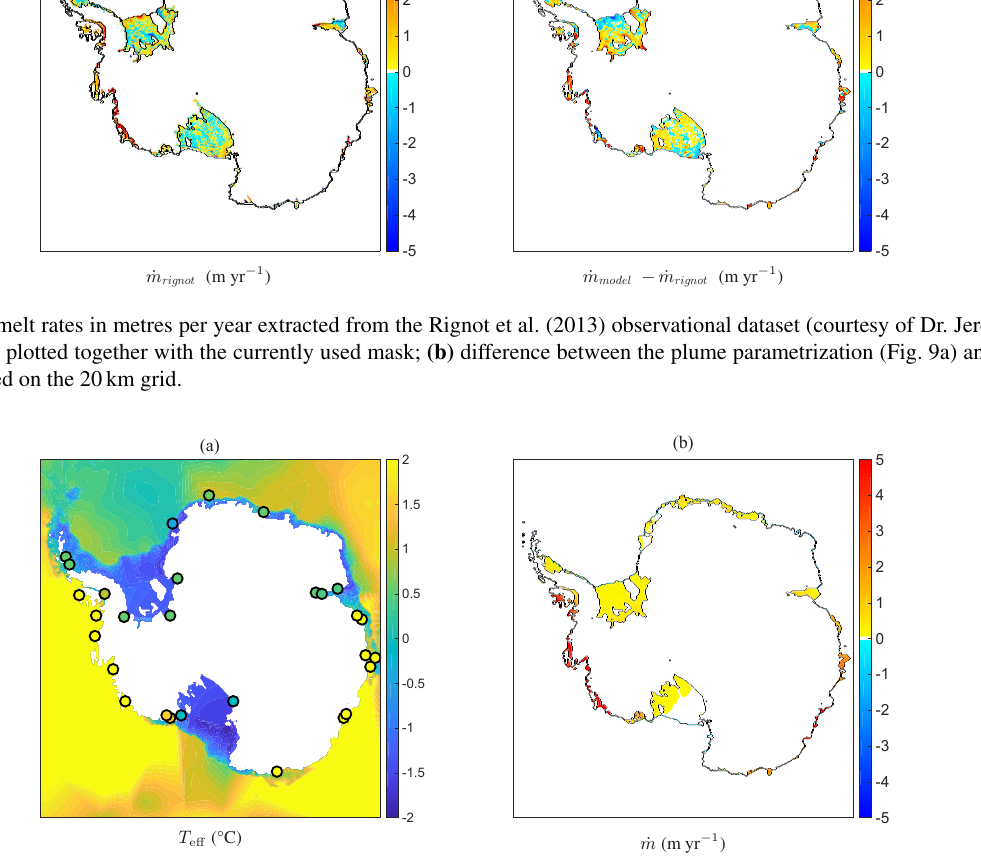
Figure 12. (a) Effective temperature field constructed in a similar way as Fig. 7b, but with different values for (cid:49)T (indicated by the circles and ranging from − 0.5 to 5.4 ◦ C), chosen in order to match the melt rates of the quadratic parametrization of DeConto and Pollard (2016) with the data of Rignot et al. (2013). (b) Basal melt rates obtained with the quadratic parametrization of DeConto and Pollard (2016) using the Bedmap2 topographic data and the effective temperature in (a) as